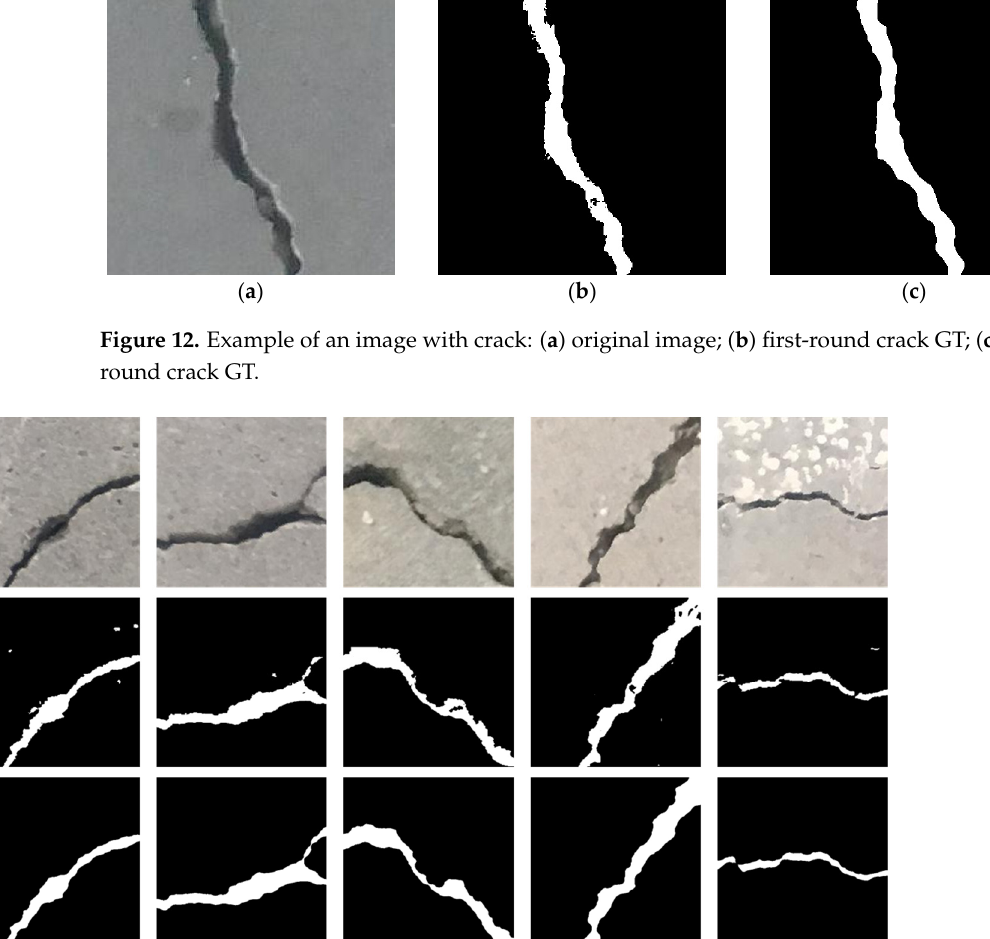
Algorithm 1: Automated Data Labeling for a Dataset